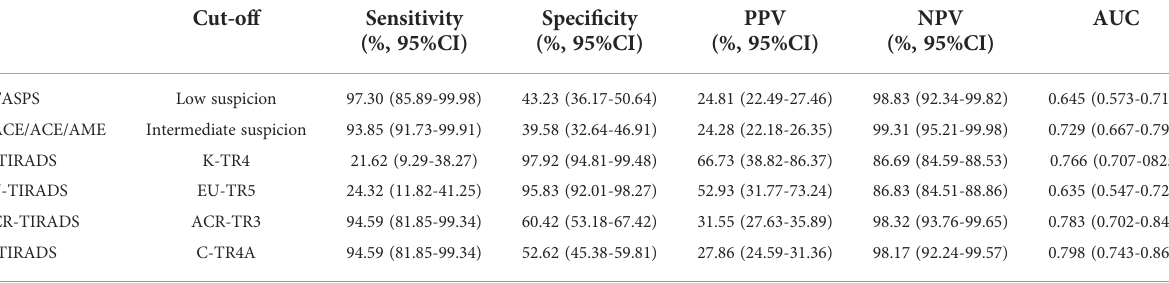
TABLE 4 The diagnostic performance of 2015 ATA, AACE/ACE/AME, K-TIRADS, EU-TIRADS, ACR-TIRADS and